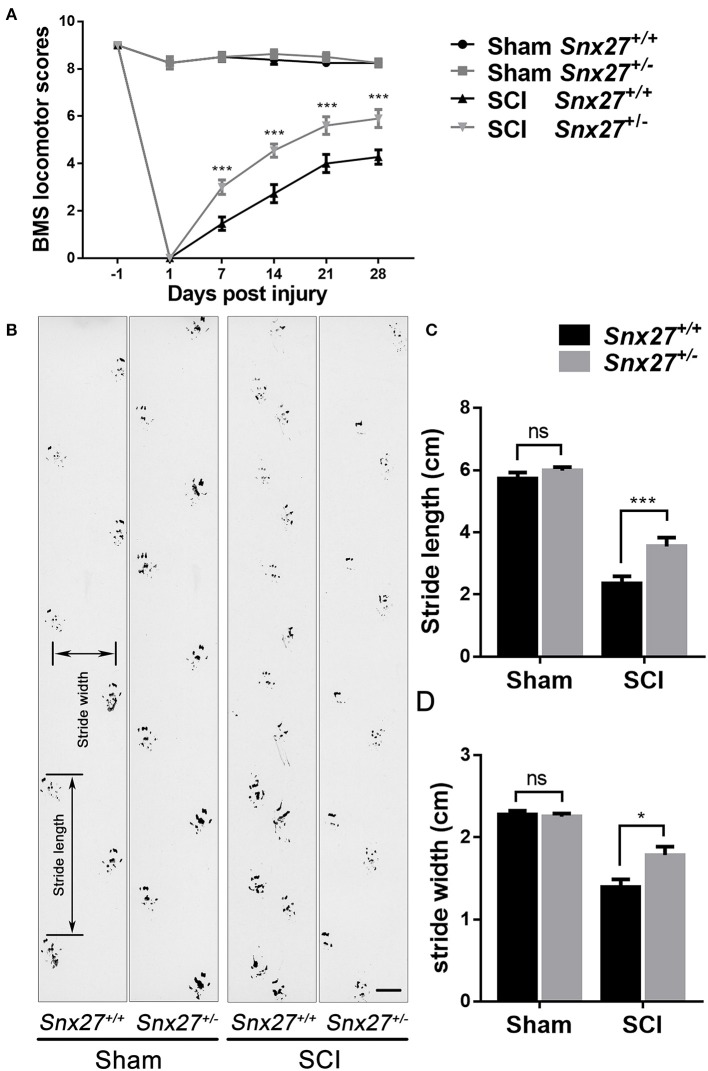
SNX27 haploinsufficiency promotes functional recovery after SCI. (A) Evaluating functional recovery of Snx27+/+ and Snx27+/− mice after SCI using BMS scoring, n = 12. Scale bar = 1cm. (B) Representative images of footprint analysis 28 days post injury. (C,D) Quantification of stride width and stride length in the footprint analysis 28 days post injury, n = 12. Values are expressed as mean ± SEM, Data were analyzed using repeated measures ANOVA followed by Bonferroni's post-hoc test, *p < 0.05, ***p < 0.001.